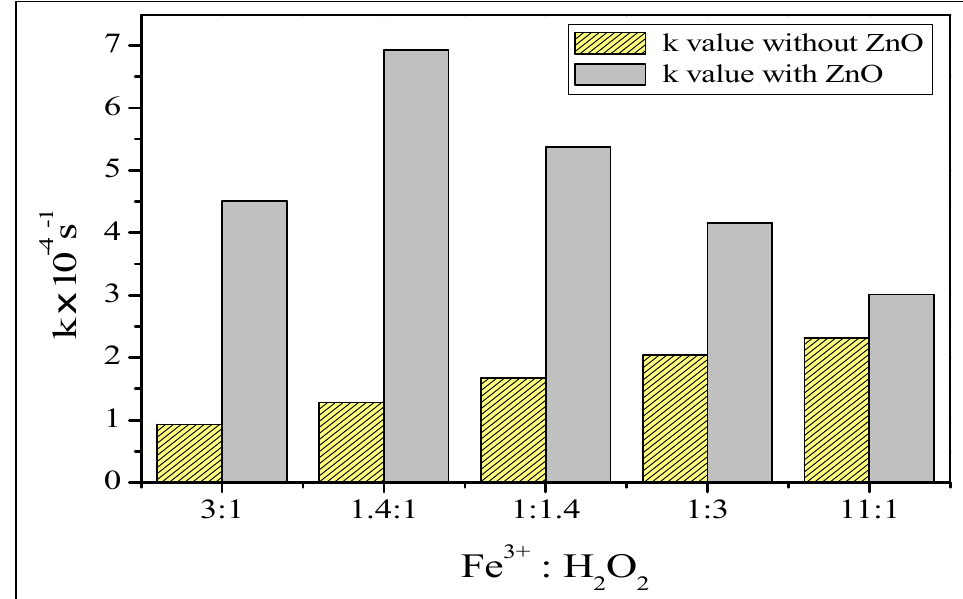
Figure 5. Effect of change in Fenton’s reagent concentration.